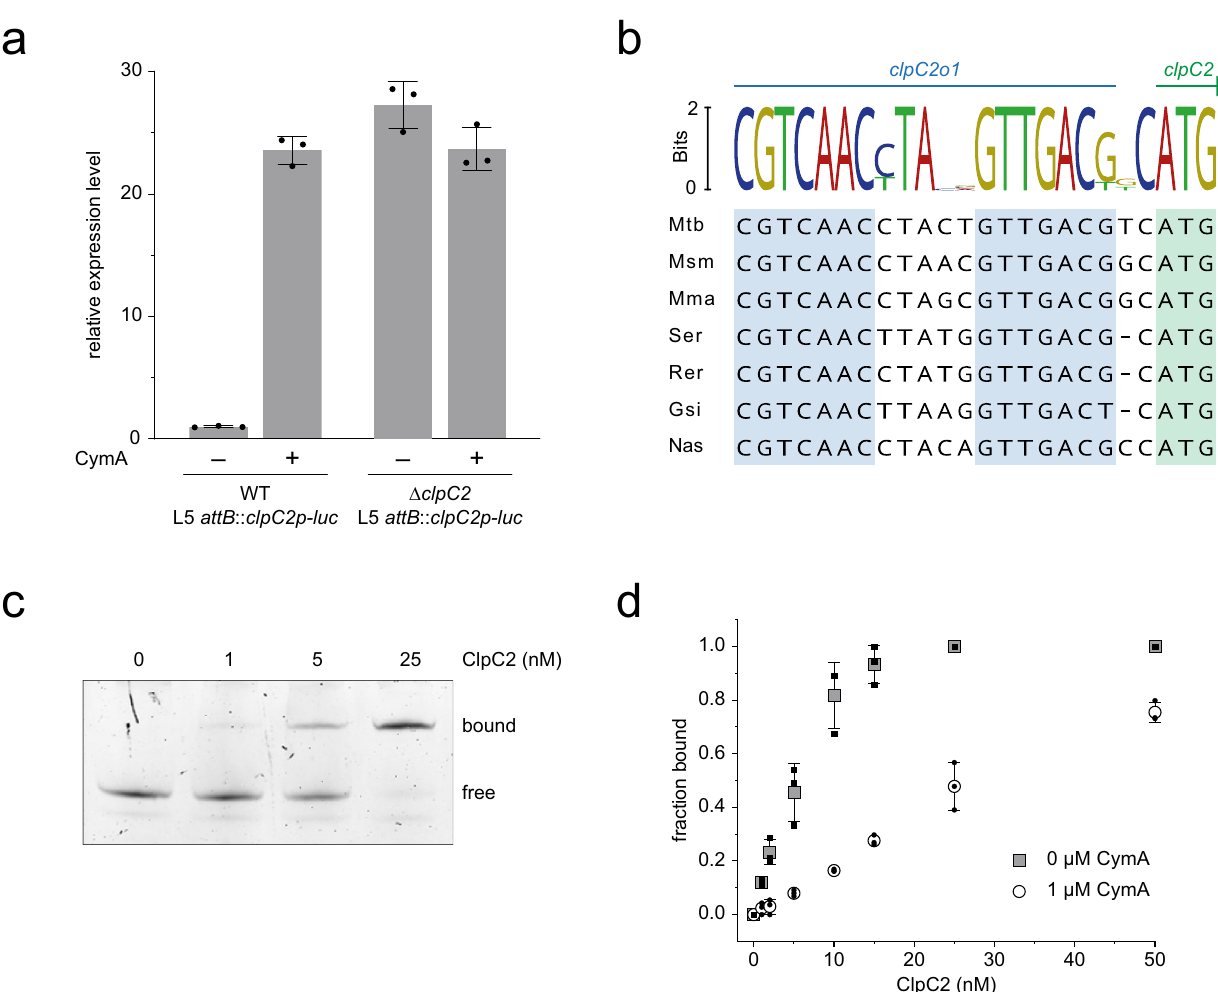
Fig. 4 ClpC2 acts as a transcription factor regulating its own expression. a The luciferase gene under the control of the clpC2 promoter was introduced into the genomes of both WT and Δ clpC2 strains via an integrative vector (see Supplementary Fig 5). Cells were harvested following the addition of CymA and the total RNA was extracted in preparation for luciferase transcript levels analysis by RT-qPCR. Luciferase transcript levels are normalised to the housekeeping gene rpoB and expression levels are expressed relative to the wild-type strain grown in the absence of CymA. Error bars depict standard deviation from three biological replicates with statistical signi fi cance determined by two-tailed unpaired Student ’ s t test. b Alignment of DNA sequences immediately upstream of the clpC2 open reading frame in a selection of actinobacteria. The start codon for clpC2 and homologues is shaded in light green. Pseudopalindromic sequence regions upstream of the start codon are shaded in light blue. The sequence logo is displayed above the alignment. Mtb, Mycobacterium tuberculosis ; Msm, Mycobacterium smegmatis ; Mma, Modestobacter marinus ; Ser, Saccharopolyspora erythraea ; Rer, Rhodococcus erythropolis ; Gsi, Gordonia sihwensis ; Nas, Nocardia asteroids . c ClpC2 DNA-binding activity was analysed by electrophoretic mobility shift assay (EMSA). 1 – 25 nM ClpC2 was added to 0.5 nM DNA that includes the putative clpC2 operator sequence. Data are representative of three independent experiments. d The binding of DNA to ClpC2 was analysed in the absence ( fi lled squares) and presence (open circles) of 1 µ M CymA. Gel band intensity was quanti fi ed by densitometry to determine the fraction of DNA bound to ClpC2. Representative gels are shown in Supplementary Fig. 8. Error bars represent the standard deviation of three independent